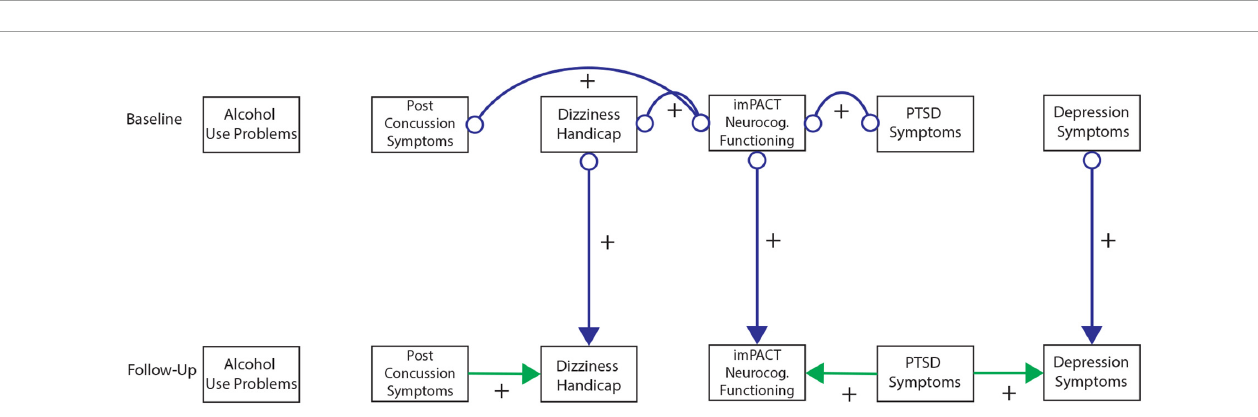
FIGURE6 Greedy Fast Causal Inference (GFCI) graph for the TEAM-TBI sample ( n = 43). Fourth independent replication of causal links between post-traumatic stress disorder (PTSD) symptoms and depression over the course of 6–12 months follow-up in the TEAM-TBI sample, leading to neurocognitive dysfunction, which are all independent of alcohol use problems. Colored arrows indicate the level and directionality of the causal edges, with + or – along the edges indicating whether these links cause increases or decreases in scores on the connected